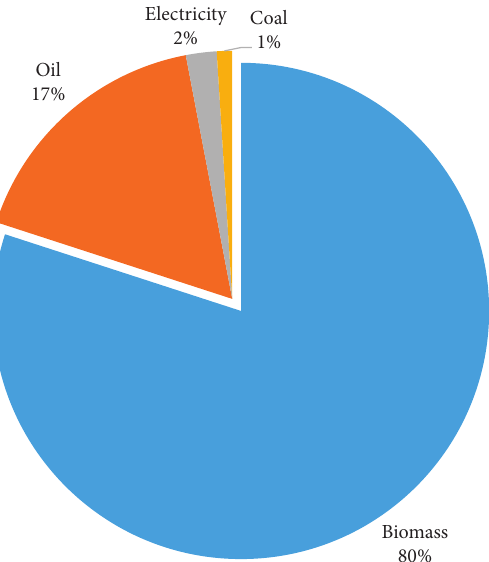
Figure 1: Percentage share of various energy resources in Madagascar up to September 2018.